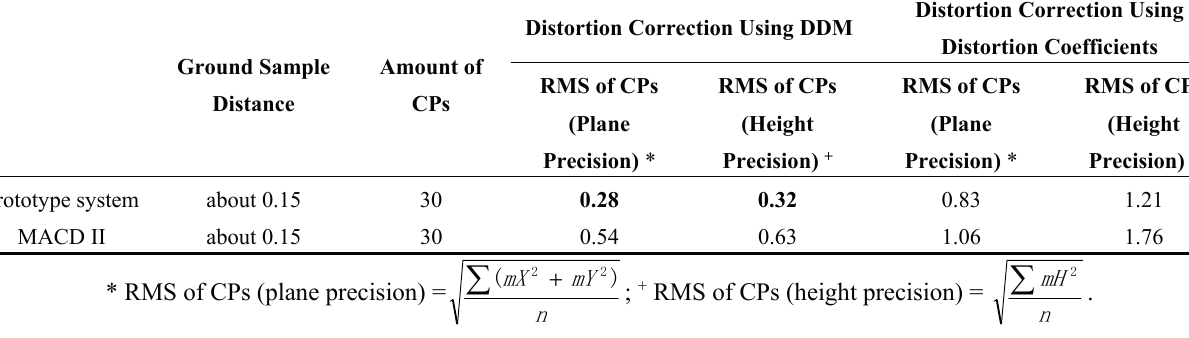
Table 8. Accuracy of the prototype system and MACDII